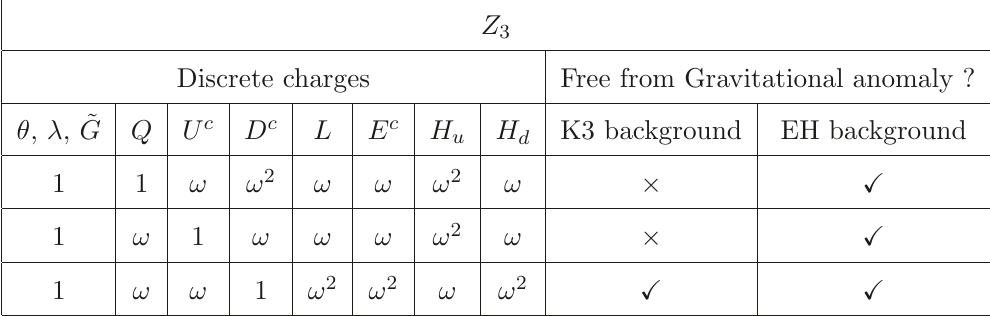
Table 10 . Z 3 symmetry solutions for the case when no /B operator is allowed up to dimension 6 level in superspace. Solutions which can be obtained by the replacements ω → ω 2 and ω 2 → ω are removed from the